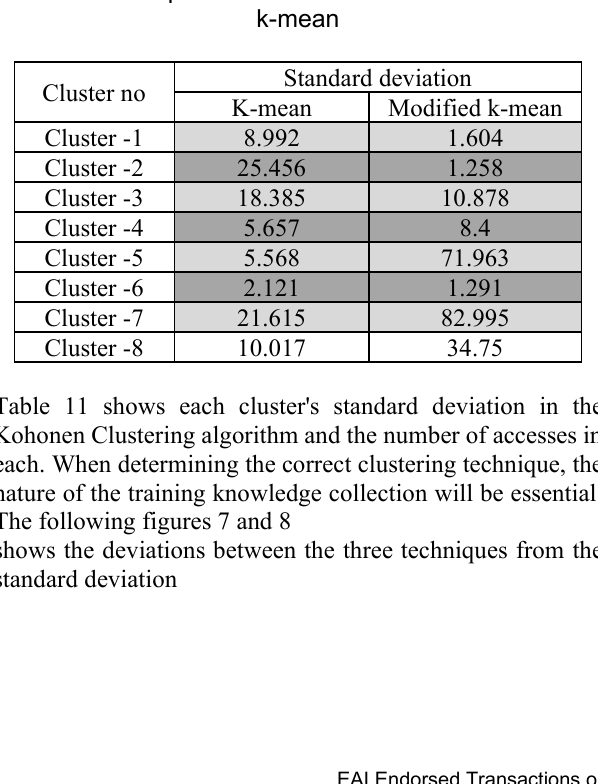
Table 10. Comparison between modified k-mean